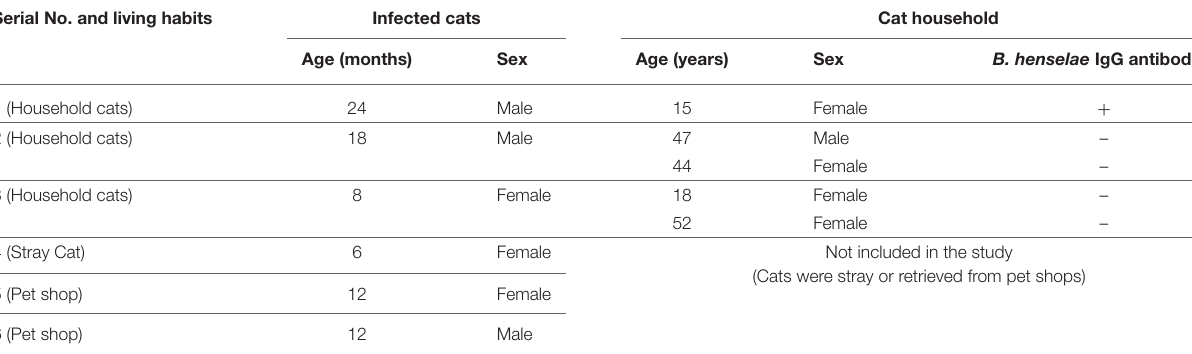
TABLE 3 | Correlation between the results B. henselae infected cats and their corresponding household. Serial No. and living